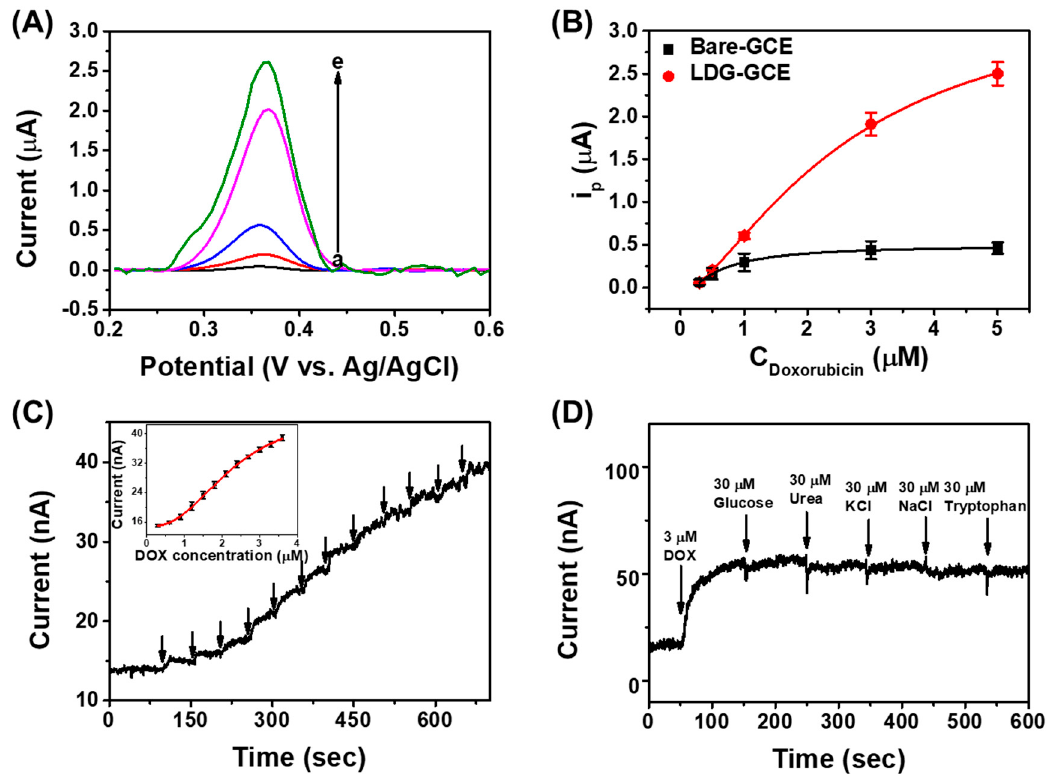
Figure 5. ( A ) Differential pulse voltammetry (DPV) curves of LDG-GCE in 10 mM PBS solution (pH = 7.4) containing various concentration of DOX (0.3, 0.5, 1.0, 3.0 and 5.0 μ M. ( B ) The calibration plots of i p vs. concentration of DOX from DPV at LDG-GCE and GCE, respectively. The average values and standard deviations were obtained based on three results. ( C ) The amperometric responses of LDG-GCE to the successive addition of DOX from 0.3 μ M to 3.6 μ M at 0.366 V vs. Ag/AgCl. (Inset: The calibration plot from the amperometric measurements) ( D ) The amperometric responses of LDG-GCE to the successive addition of 3 µ M DOX, 30 µ M glucose, 30 µ M urea, 30 µ M KCl, 30 µ M NaCl, and 30 µ M tryptophan. at 0.366 V vs. Ag /